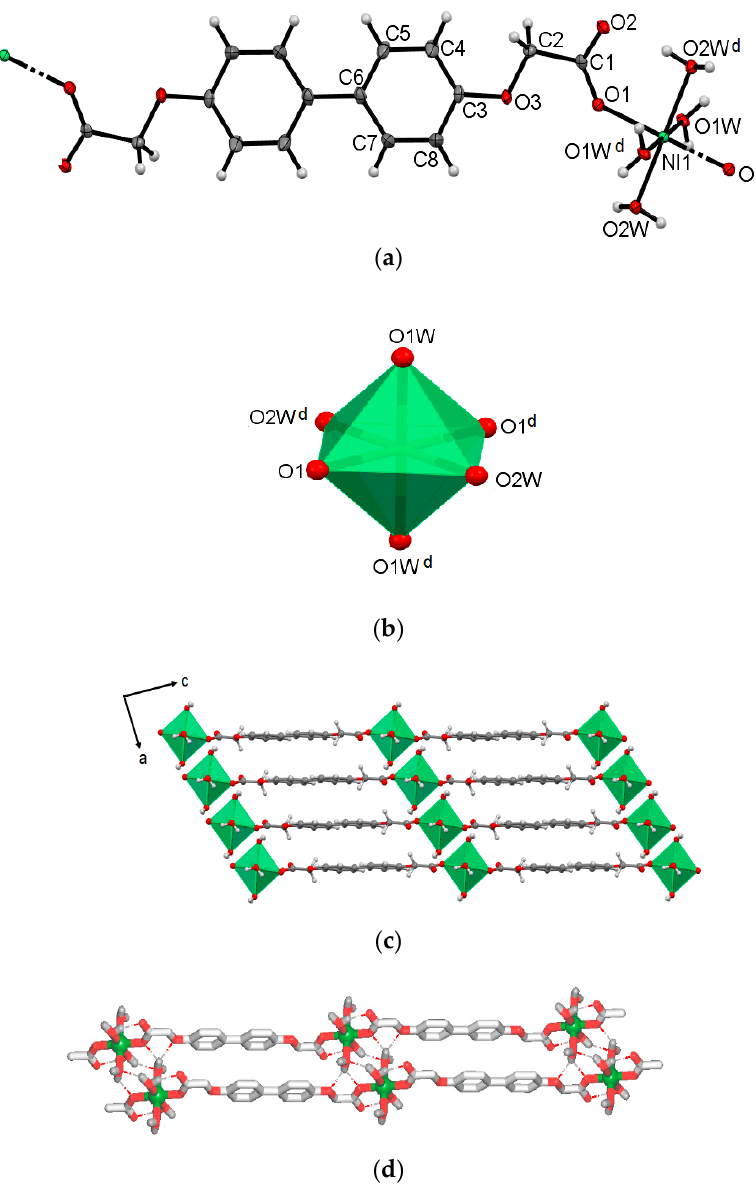
Figure 3. Structural fragments of 2 . ( a ) Coordination environment of Ni center; 50% probability level ellipsoids are drawn; ( b ) coordination polyhedron of Ni atom; and ( c ) crystal packing with polyhedral representation of Ni atoms in view along the b axis. Symmetry code: (d) –x + 2, − y + 1, z + 1. ( d ) H-bond network (dotted lines) in compound 2